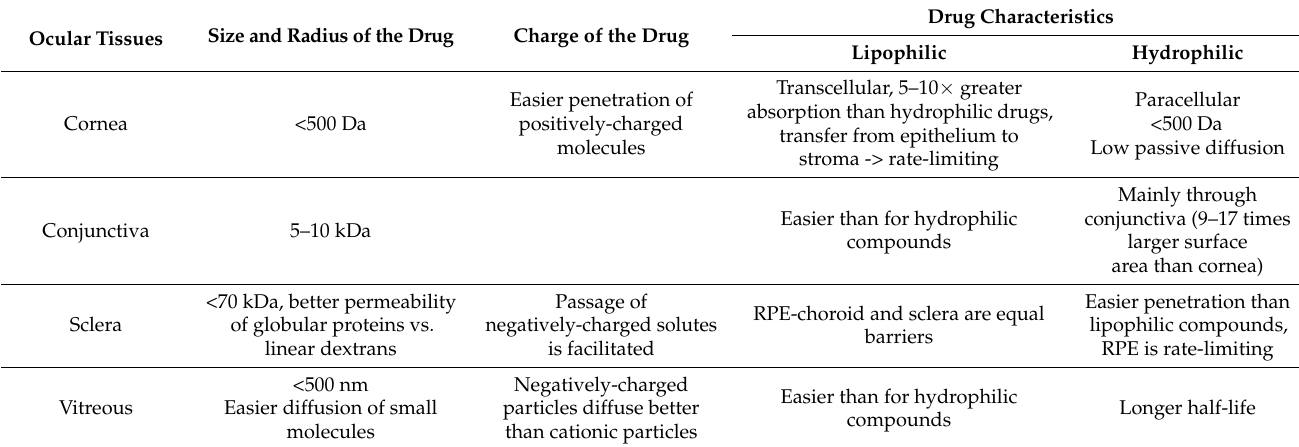
Table 1. Influence of drug characteristics on transport of topically applied drugs across ocular